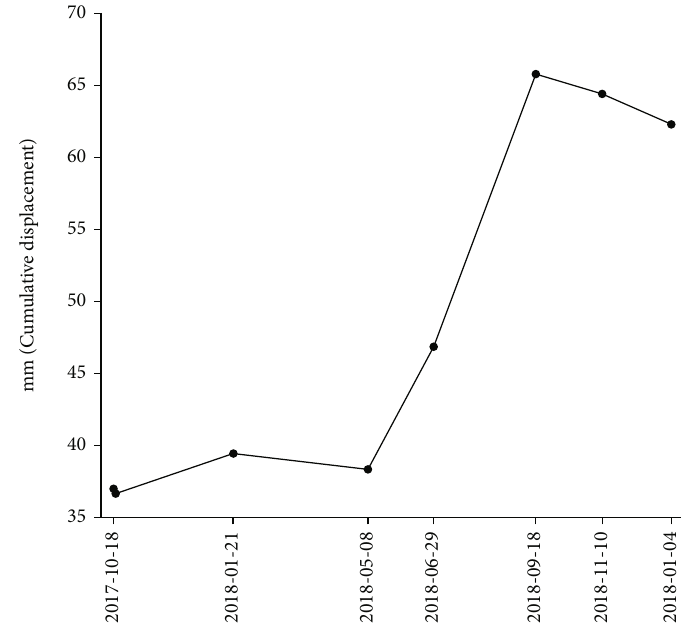
Figure 7: Cumulative displacement-time curve at 0.5m of borehole ZK4-1.